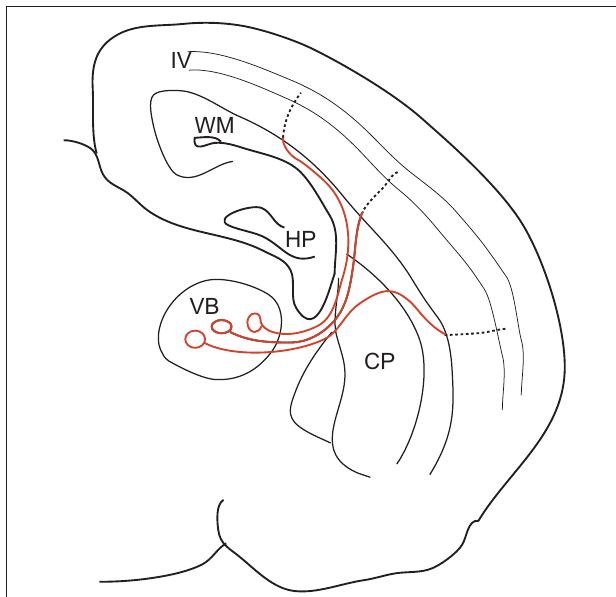
FIGURE 1 | A schematic illustration of the thalamocortical pathway, showing regional differences in CV. By having a 10-fold faster CV from the VB to the WM (red lines), most of the conduction time is spent on the intracortical regions (dotted lines), whose length is generally constant due to the homogeneous structure of the cortex. Thus, isochronicity of conduction time from VB to layer IV cells is achieved. VB: ventrobasal nucleus of thalamus, WM: white matter, HP: hippocampus, CP: caudate putamen, IV: layer 4 [Cited from Salami et al., PNAS 100, 6174–6179